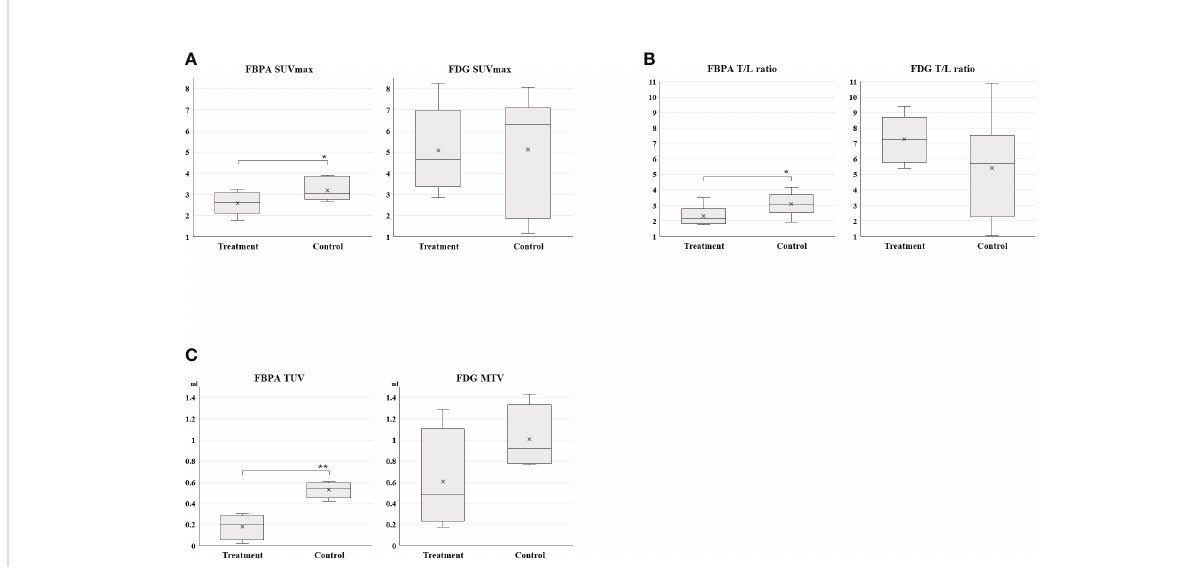
FIGURE 3 (3 A : SUVmax, 3 B : T/L ratio, 3 C : TUV and MTV) Box charts of quantitative PET parameters in the treatment and control groups Statistically smaller values of SUVmax, T/L ratio, and TUV were observed in the treatment group than the control group on FBPA PET (*p <0.05, **p < 0.005). A substantial overlap was observed in these parameters on FDG